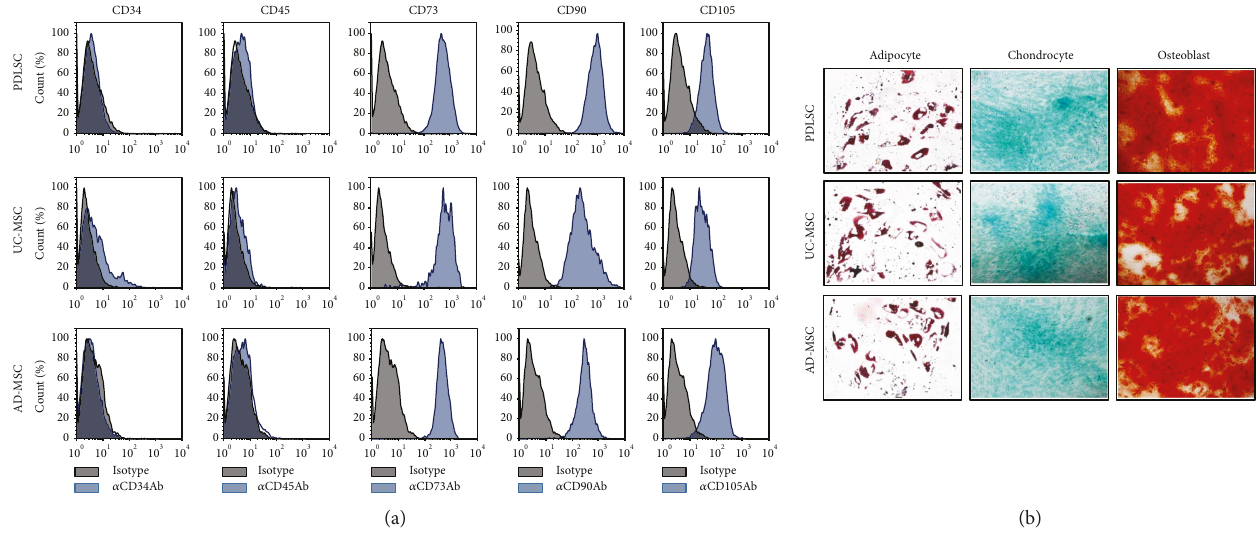
Figure 1: Characterization of human MSCs derived from the periodontal ligament (PDLSC), from the umbilical cord (UC-MSCs), and from the adipose tissue (AD-MSCs). (a) Cells were cultured for fi ve to eight passages, harvested, labeled with antibodies against CD34, CD45, CD73, CD90, or CD105, and analyzed by fl ow cytometry. Black histograms indicate negative controls, and blue histograms represent PDLSCs stained with the indicated antibodies. (b) Cells were induced to di ff erentiate into adipocytes, chondrocytes, or osteoblasts using the appropriate culture medium. Oil Red O, Safranin O, or Alizarin Red staining of adipocytes, chondrocytes, or osteoblasts was performed on days 14, 21, or 28 postinduction, respectively. All experiments were performed independently at least three times, and representative fi gures are